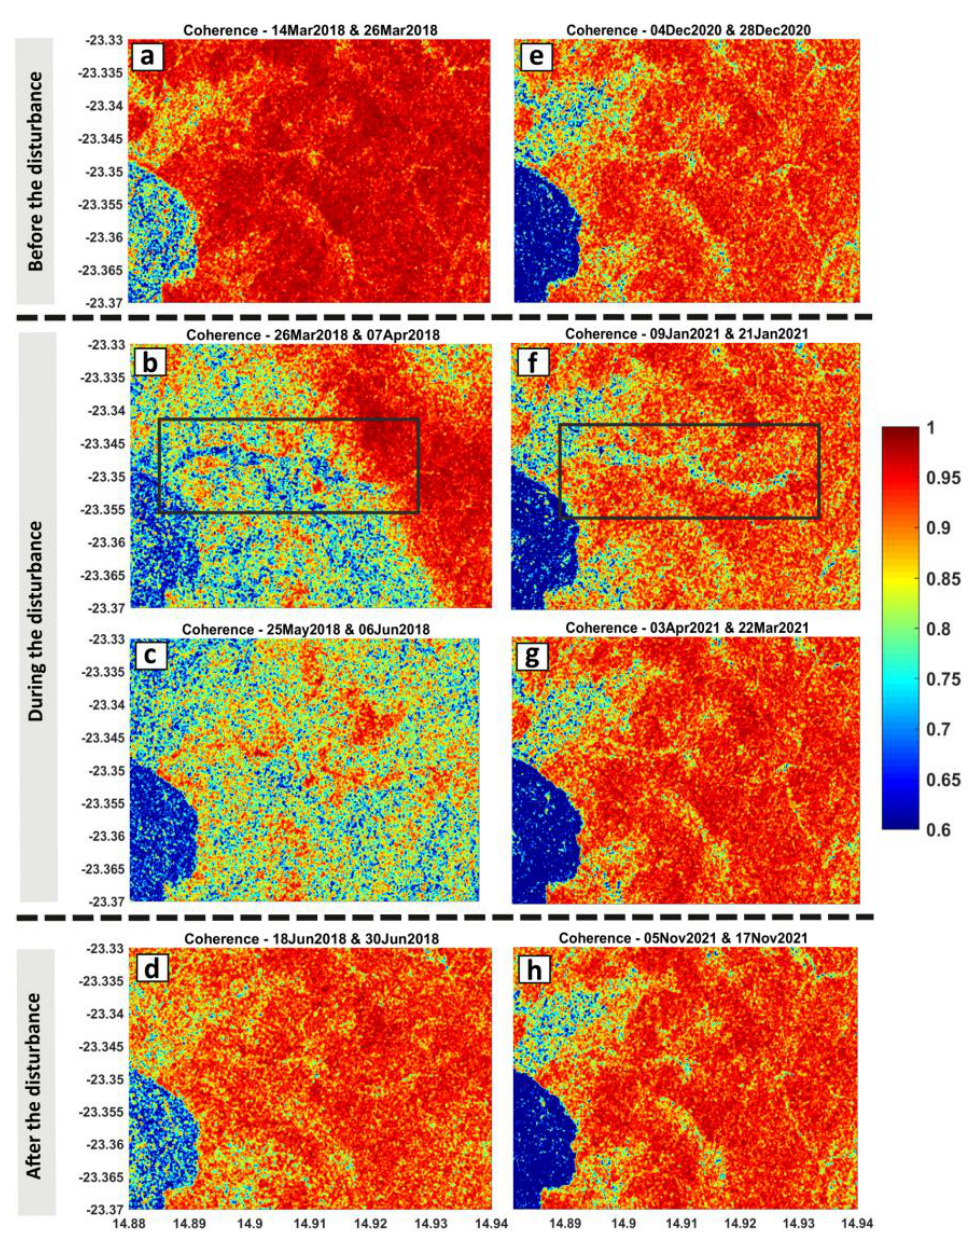
Figure 8. Coherence maps associated with the tributary area at Klipneus in Figure 7a, adjacent to the Kuiseb river channel. ( a – d ) are coherence maps associated with a local rain event in 2018; ( e – h ) are coherence maps associated with a flood event in 2021.